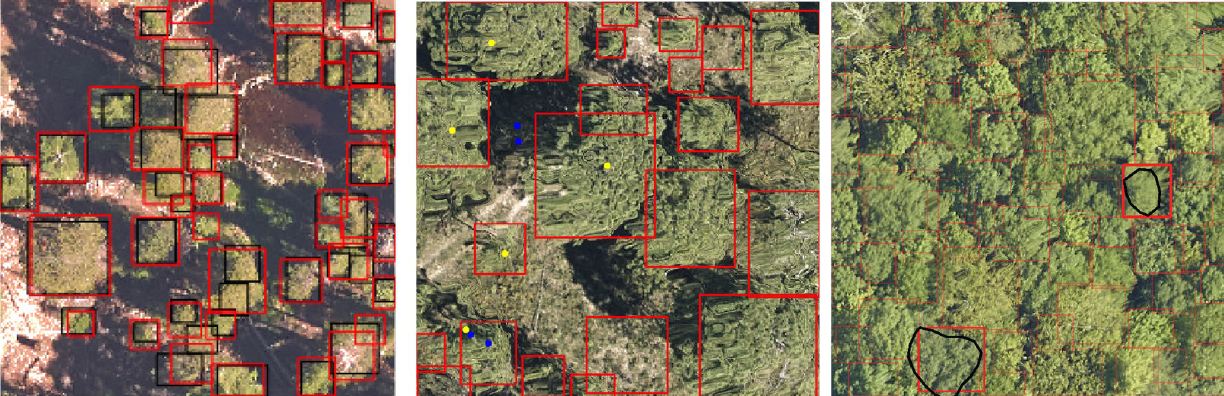
Fig 9. Example predictions using the DeepForest algorithm. Left) DeepForest predictions in red and compared to image-annotated crowns in black from Teakettle Canyon, California. Middle) DeepForest predictions in red are compared to field-collected stems, with matching stems in yellow and missing stems in blue, from Jones Ecological Research Center, Georgia. Right) DeepForest predictions in red with the field-annotated crown in black from Mountain Lake Biological Station, Virginia. The matching prediction is shown in bold while the other predictions are faded for visibility.